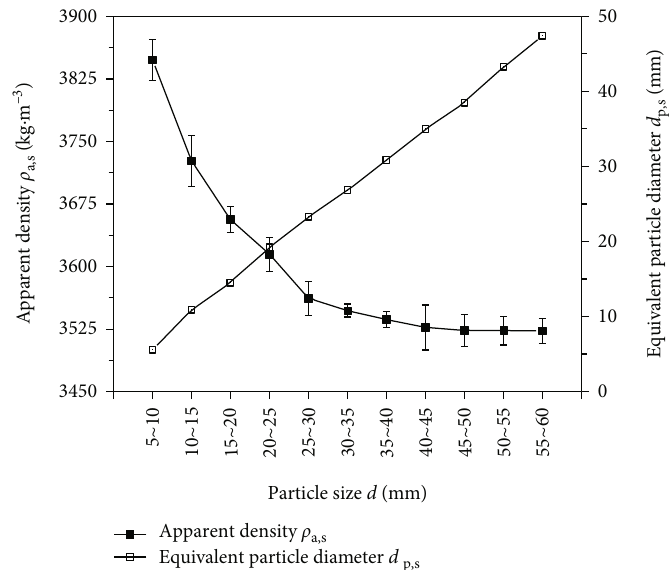
Figure 4: The apparent density ρ